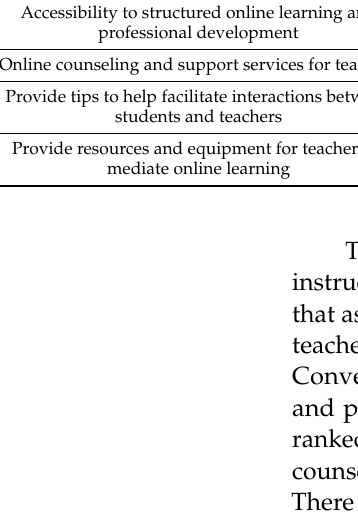
Table 3. Learning aids to engage students in remote/online instruction. Note: P-values were determined by Fisher’s exact test. Least/LessEffective MediumEffectiveness Most/MoreEffective p -Value Stratified SurveyQuestion Total N = 84 Response N